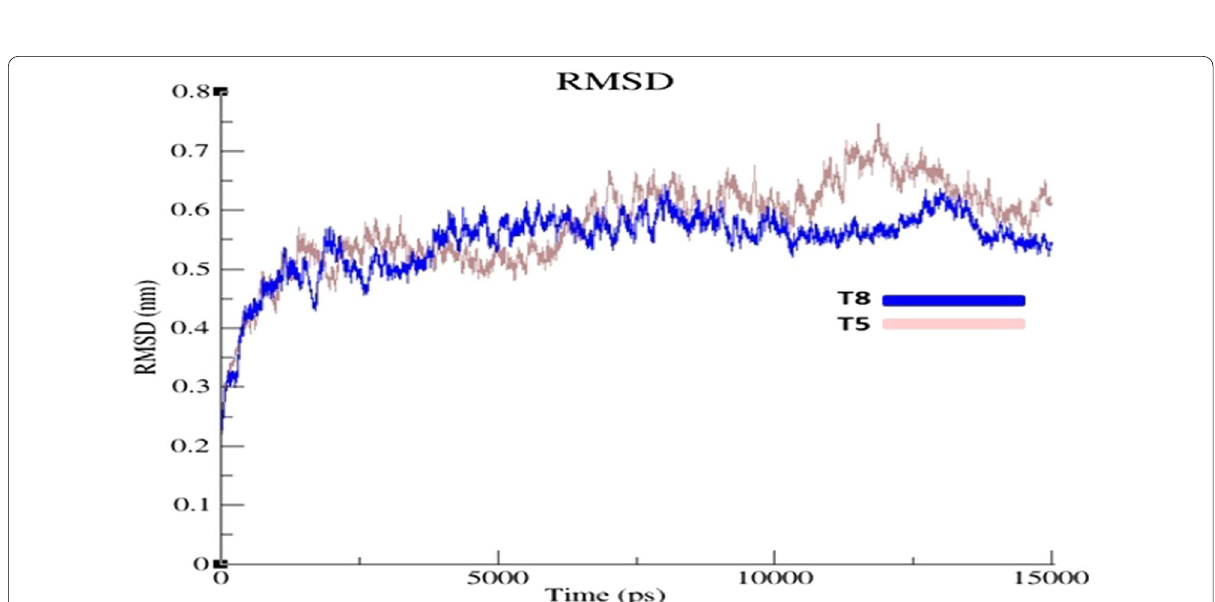
Fig. 5 RMSD graphs of T5 and T8 targeted protein at different time scales from 0 to 15,000